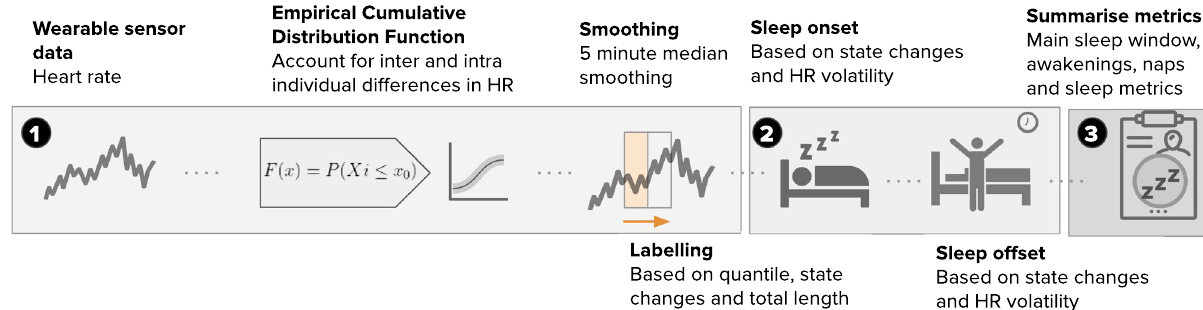
Figure 2. Heart rate sleep algorithm description. The approach can be broken down into three distinct steps. The first step, involves obtaining the wearable sensor HR data, pre-processing that data and setting initial sleep blocks through ECDF quantile thresholds Q . Blocks longer than L minutes are kept and merged with other blocks if their gap is smaller than G minutes. We extract the limits of the resulting blocks as sleep candidate for sleep onset and offset. Next, rolling heart rate volatility is used to refine these candidate times by finding nearby periods where this volatility is high. Finally, nap and awakenings are labeled, the former coming from the candidate sleep blocks not included in the largest sleep window, while the latter are short periods (<60 minutes) within the sleep window when the heart rate exceeds the daytime threshold. A detailed description of this algorithm and parameters used can be found in the methods section. The icons used in this figure are licensed under Creative Commons by thenounproject.com.